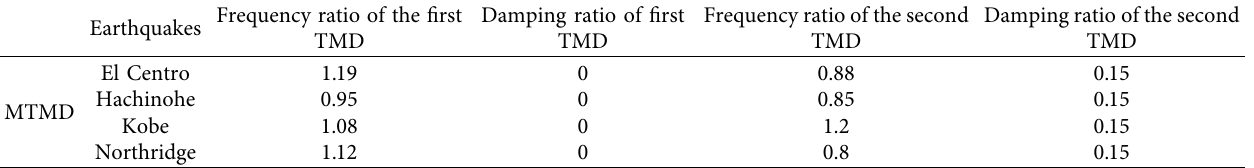
Table 4: Damping ratio and frequency ratio of MTMD.